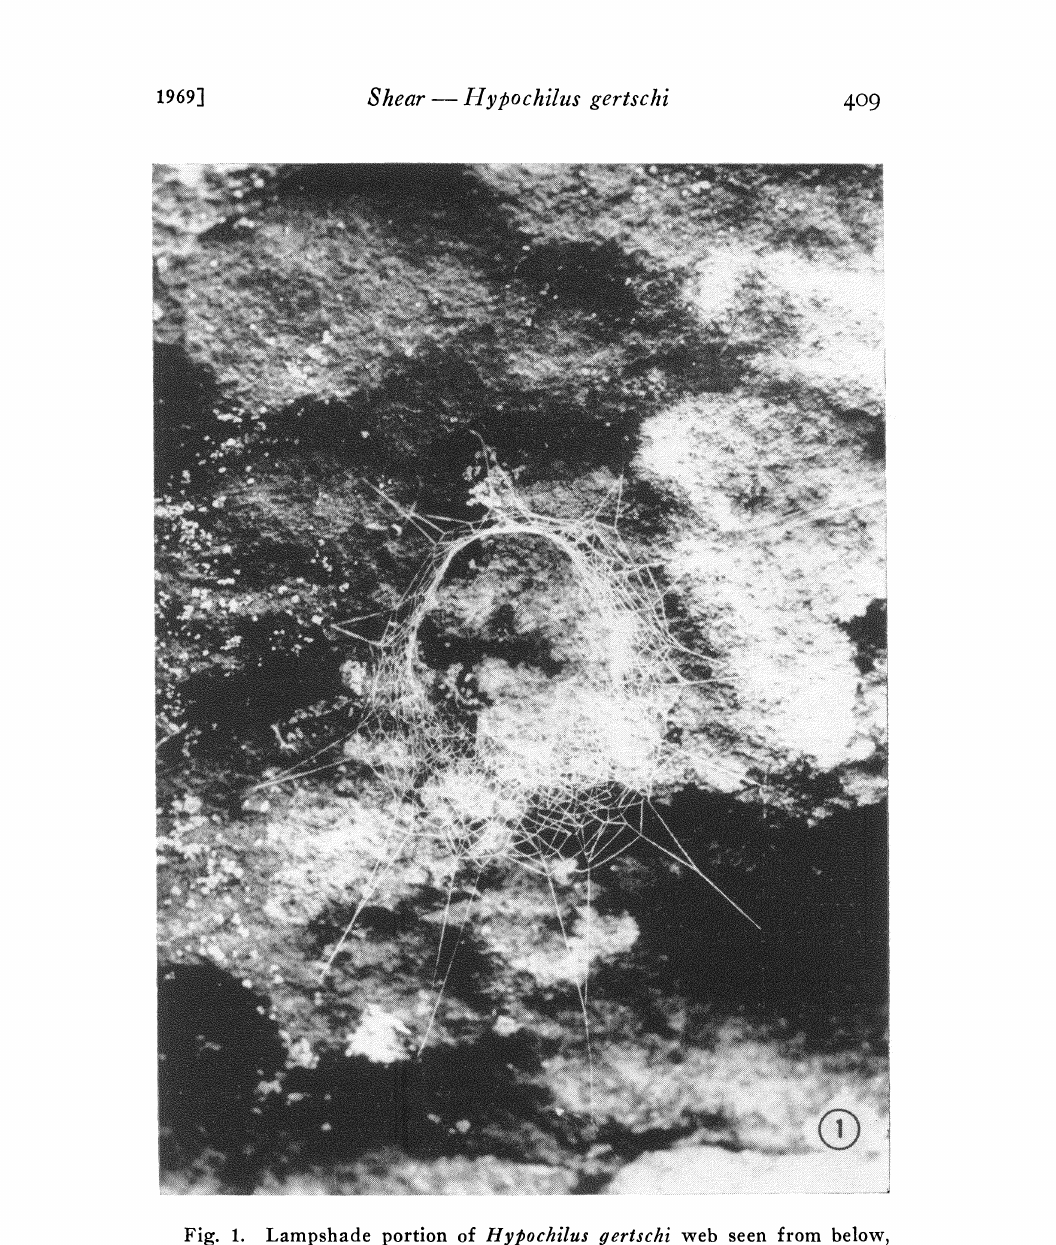
Fig. 1. Lampshade portion of Hylochilus gertschi web seen from below, powdered with cornstarch. The spider is just above the center of the web; note the effective cryptic coloration. About 2/3 actual